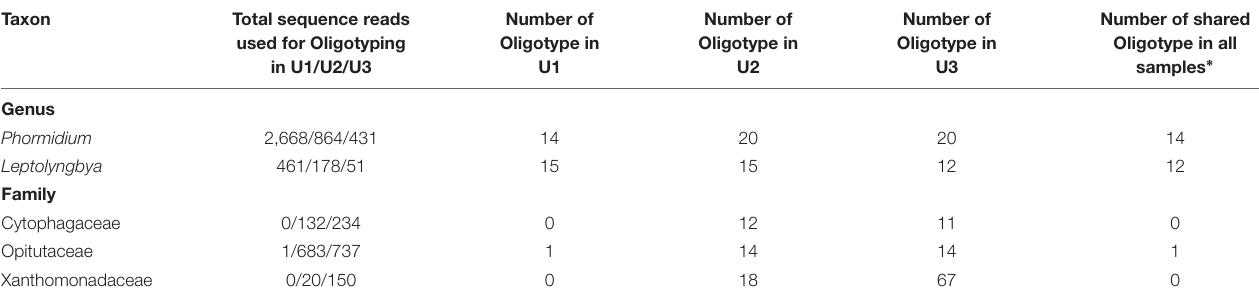
FIGURE 3 | Oligotype profiles describing the distribution and abundances of each dominant microbial taxon in three laminae (U1, U2, and U3). Color bars within each (but not between) graph represent the oligotypes within (A) Phormidium , (B) Leptolyngbya , (C) Cytophagaceae, (D) Opitutaceae, and (E) Xanthomonadaceae. The gray bars above each color graph represent the abundance of sequence reads that were assigned to different bacterial taxa. Oligotyping analyses were performed using the open-source pipeline for oligotyping, available at http://oligotyping.org. Note that no Cytophagaceae and Xanthomonadaceae sequences were identified in U1 lamina, as shown in graphs (C,E) . TABLE 2 | Oligotyping results for the U1, U2, and U3 laminae of a large conical mat samples from Lake Untersee used in this